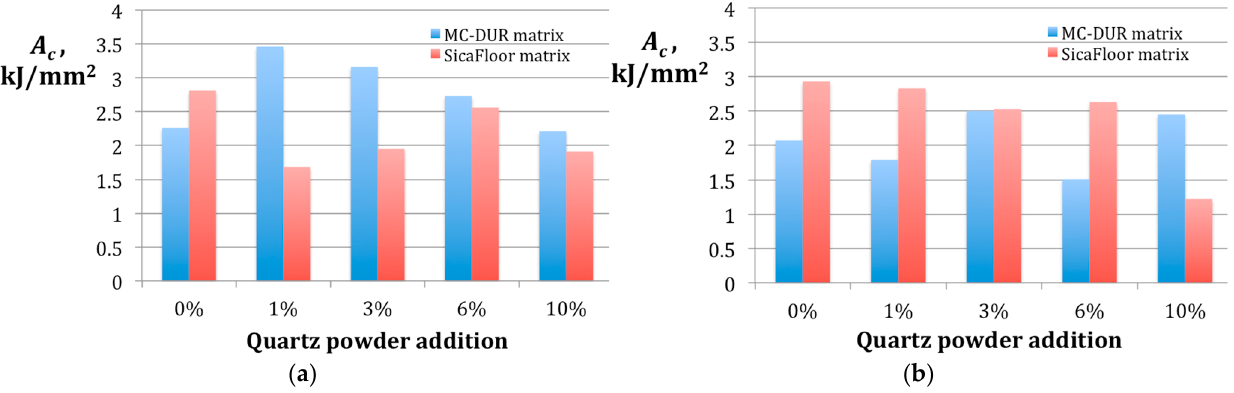
Figure 10. The results of the impact strength A c measurement for the specimens of the different particulate filler proportions in the polymer matrices MC-DUR 1200VK and Sikafloor 156 produced using different binders: ( a ) with the emulsion binder; ( b ) with the powder binder. It is seen from Figure 10a that the highest impact strength of A c = 3.46 kJ/mm 2 was reached for the MC-DUR matrix-based composite treated with the emulsion binder,